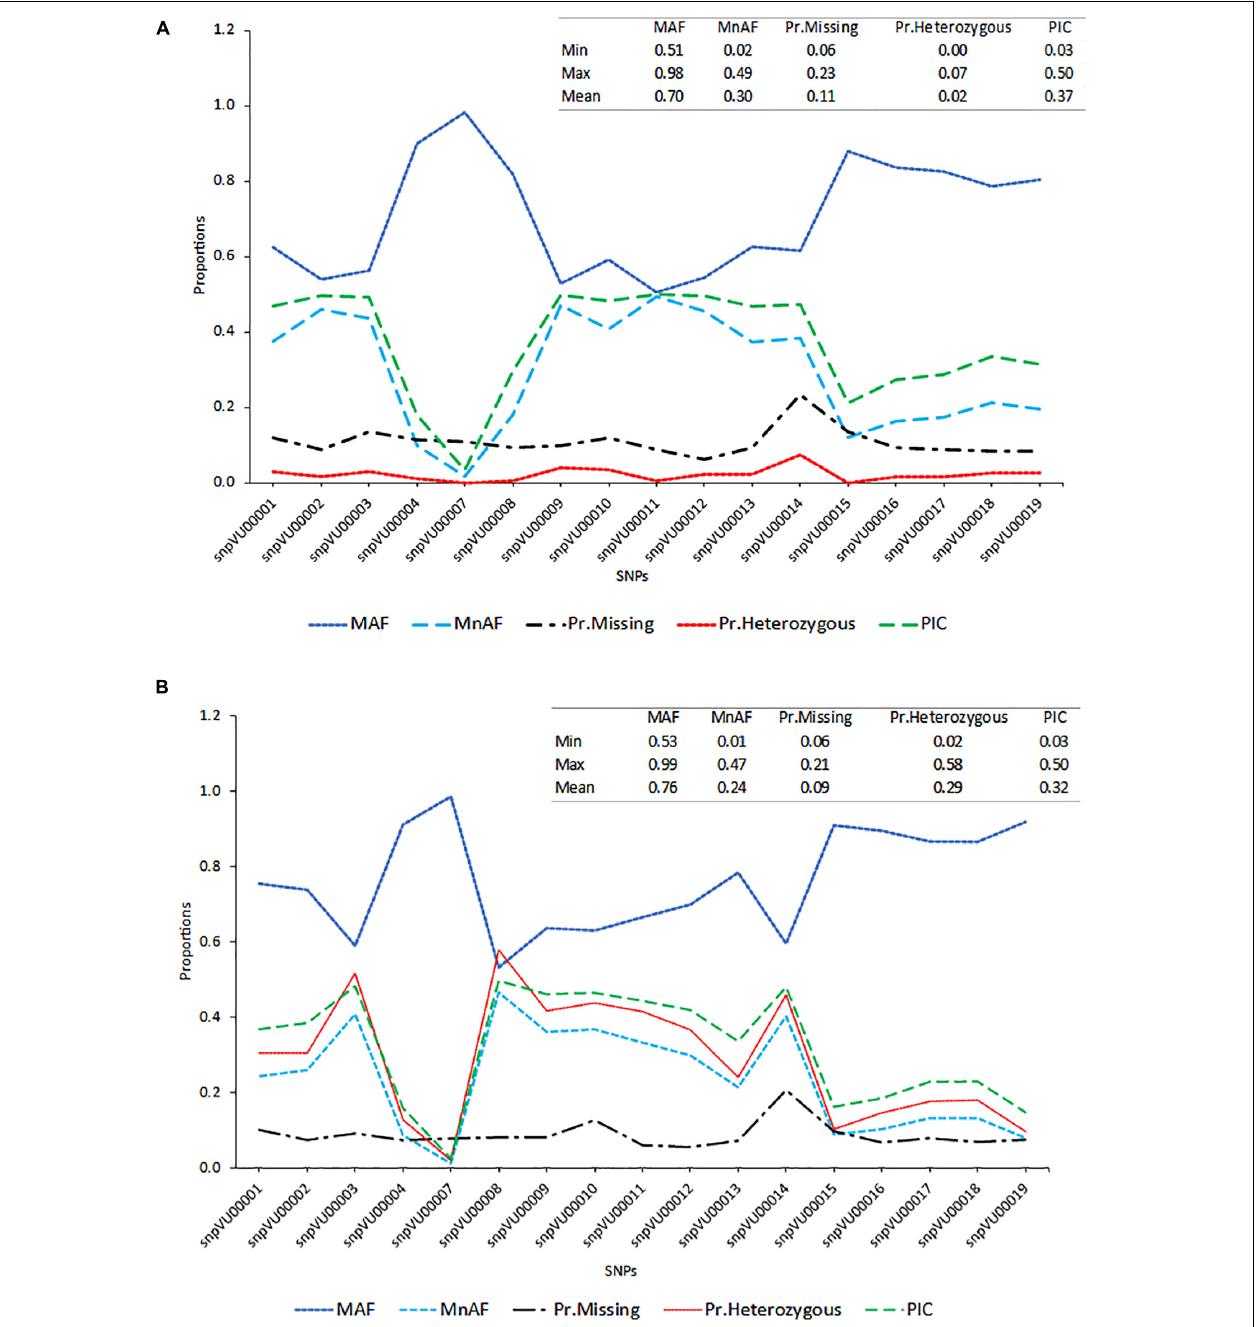
FIGURE 2 | Distribution of major allele frequency (MAF), minor allele frequency (MnAF), proportion of locus heterozygosity (Pr.Heterozygous), proportion of missing data (Pr.Missing), and polymorphism information content (PIC). (A) Line graph based on combined data of both F 1 s and their parents. (B) Line graph based on data for parents alone. Inserts on the top right-hand corner of both graphs depicts summary statistics (Minimum, Maximum, and Mean values) of the estimated parameters.